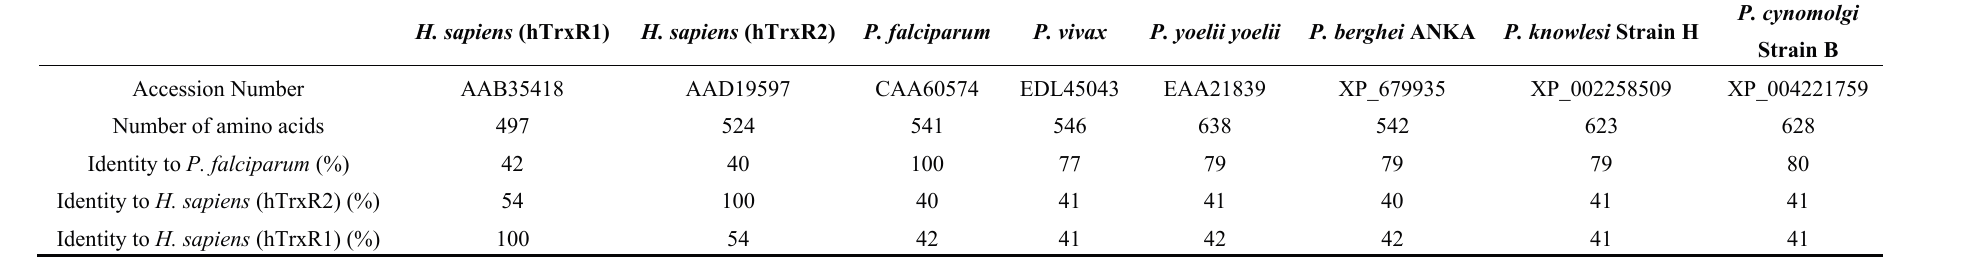
Table 1 . Amino acid sequence identities between Plasmodium sp . TrxRs the human cytosolic and mitochondrial isoforms.